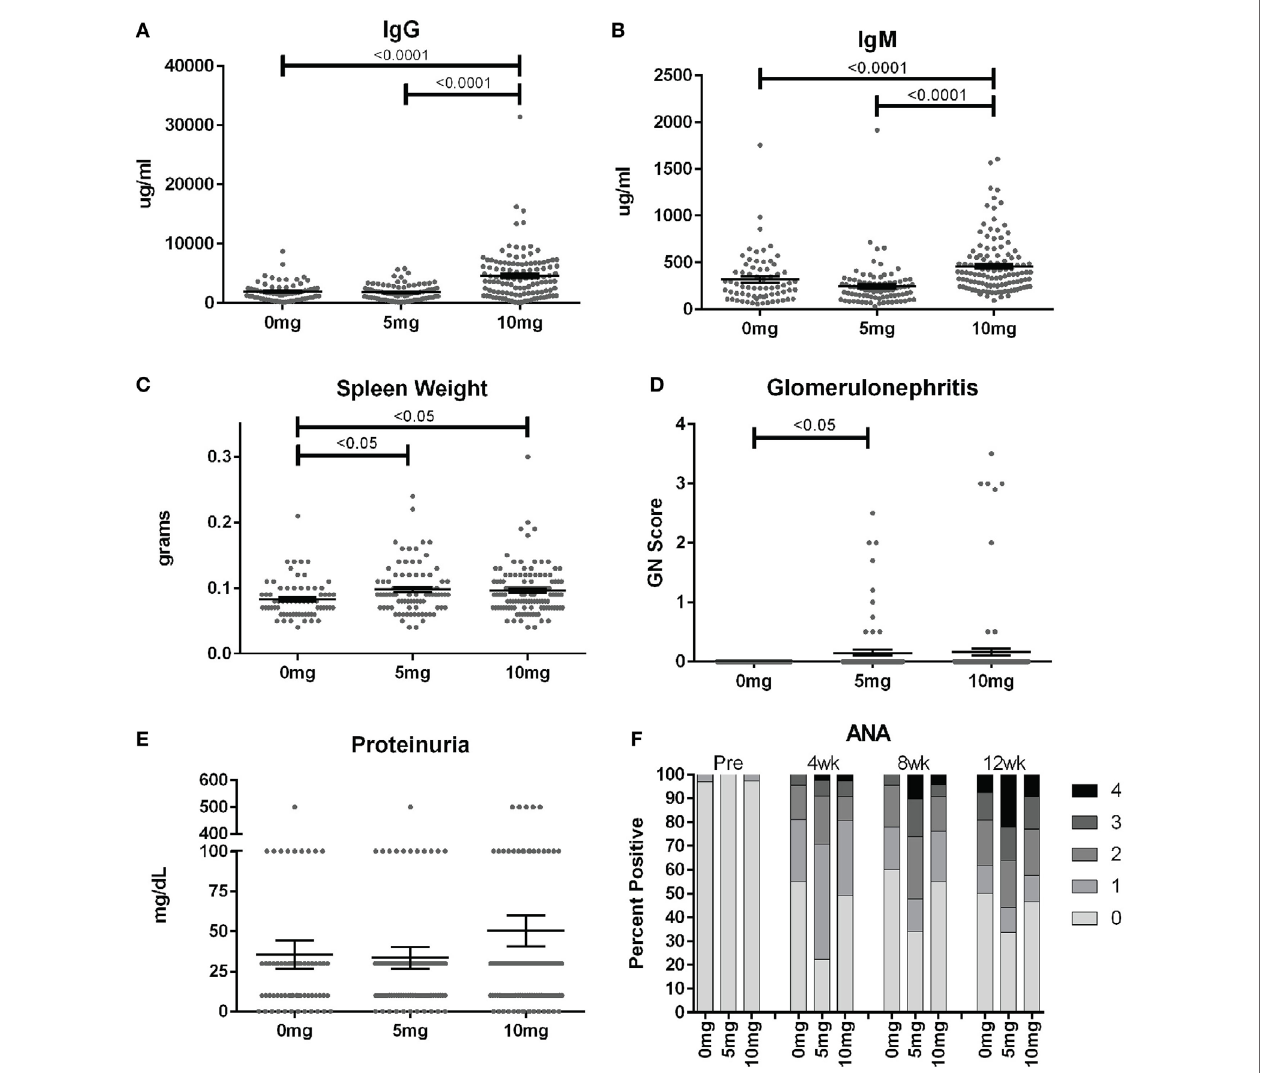
FigUre 3 | Indices of silica-induced autoimmunity in diversity outbred mice. Mice were exposed transorally to crystalline silica in PBS (see Figure 1 ) before blood was collected for determination of serum (a) IgG and (B) IgM and (c) spleen weight. (D) Glomerulonephritis was determined by reviewing and scoring Periodic Acid–Schiff-stained kidney sections and (e) proteinuria was measured in the urine using Chemstrips. (F) Blood was collected prior to exposure and every 4 weeks thereafter for determination of serum anti-nuclear antibodies by